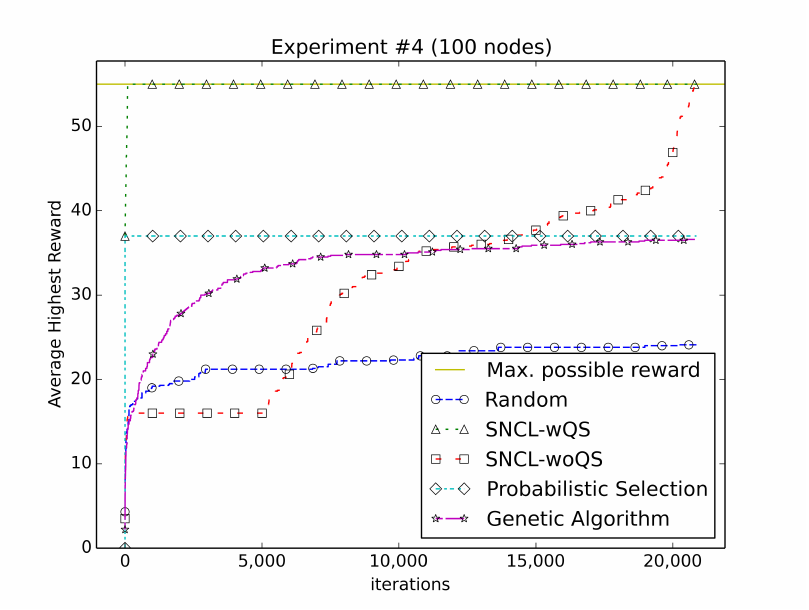
Figure 6. Using reward Equation (4).